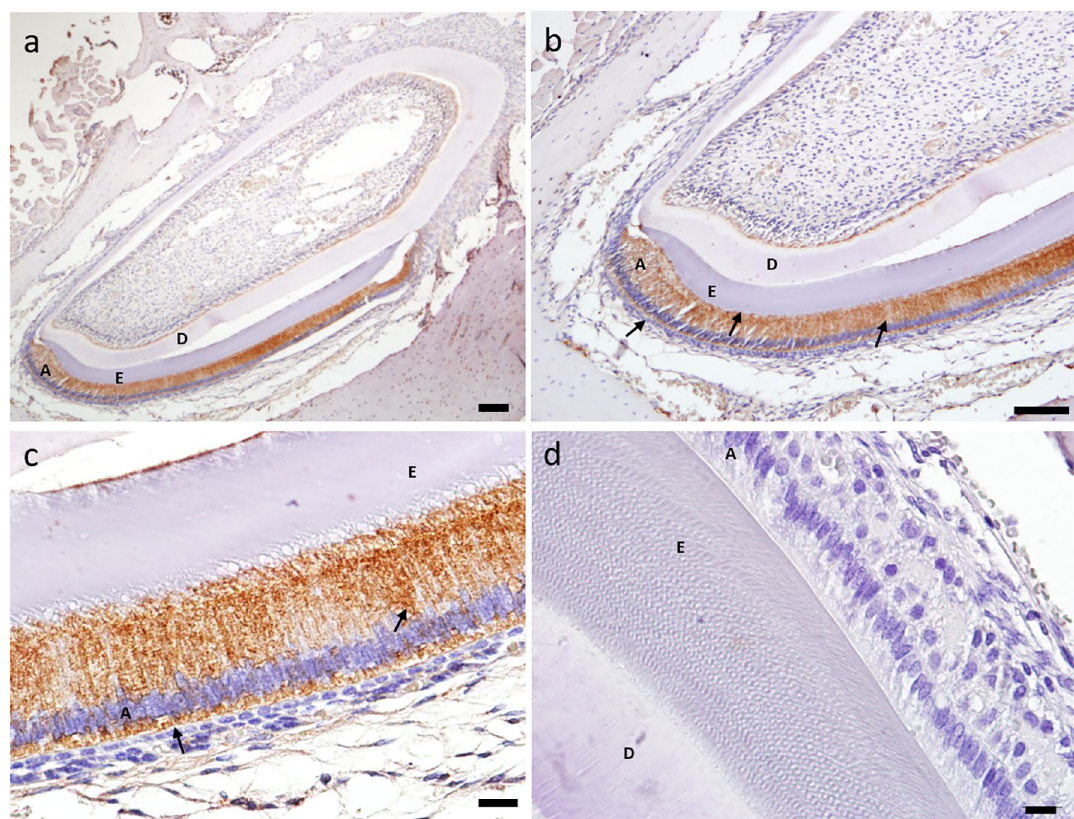
Figure 3. Control group (n = 20) shows an intense COX-2 expression in the ameloblast layer (4×/ scale = 200 µm) ( a ), (10× / scale = 100 µm) ( b ), (20×/scale = 50 µm) ( c ). In the negative control group, in